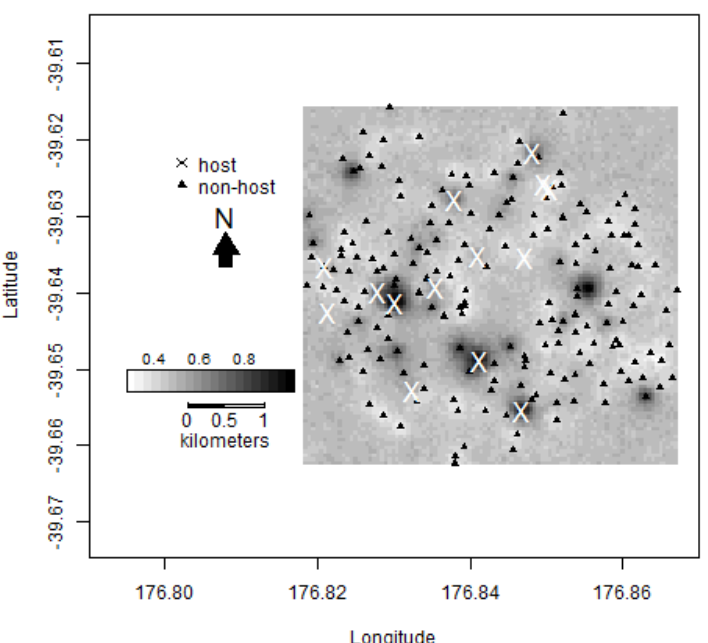
Figure 5. Spatial interpolation giving the probability of a location exceeding a total seasonal trap catch of five male codling moths ( Cydia pomonella ). The darker areas are of regions of high probabilities within Hastings, and thus can be considered as areal hotspots. The crosses signify the locations of traps in host trees ( n = 15) and the triangles signify the locations of traps in non-host trees ( n = 185).